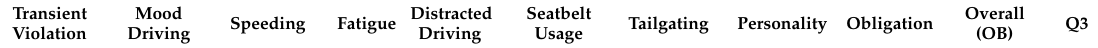
Table 6. Association between psychosocial-behavioral parameters and traffic